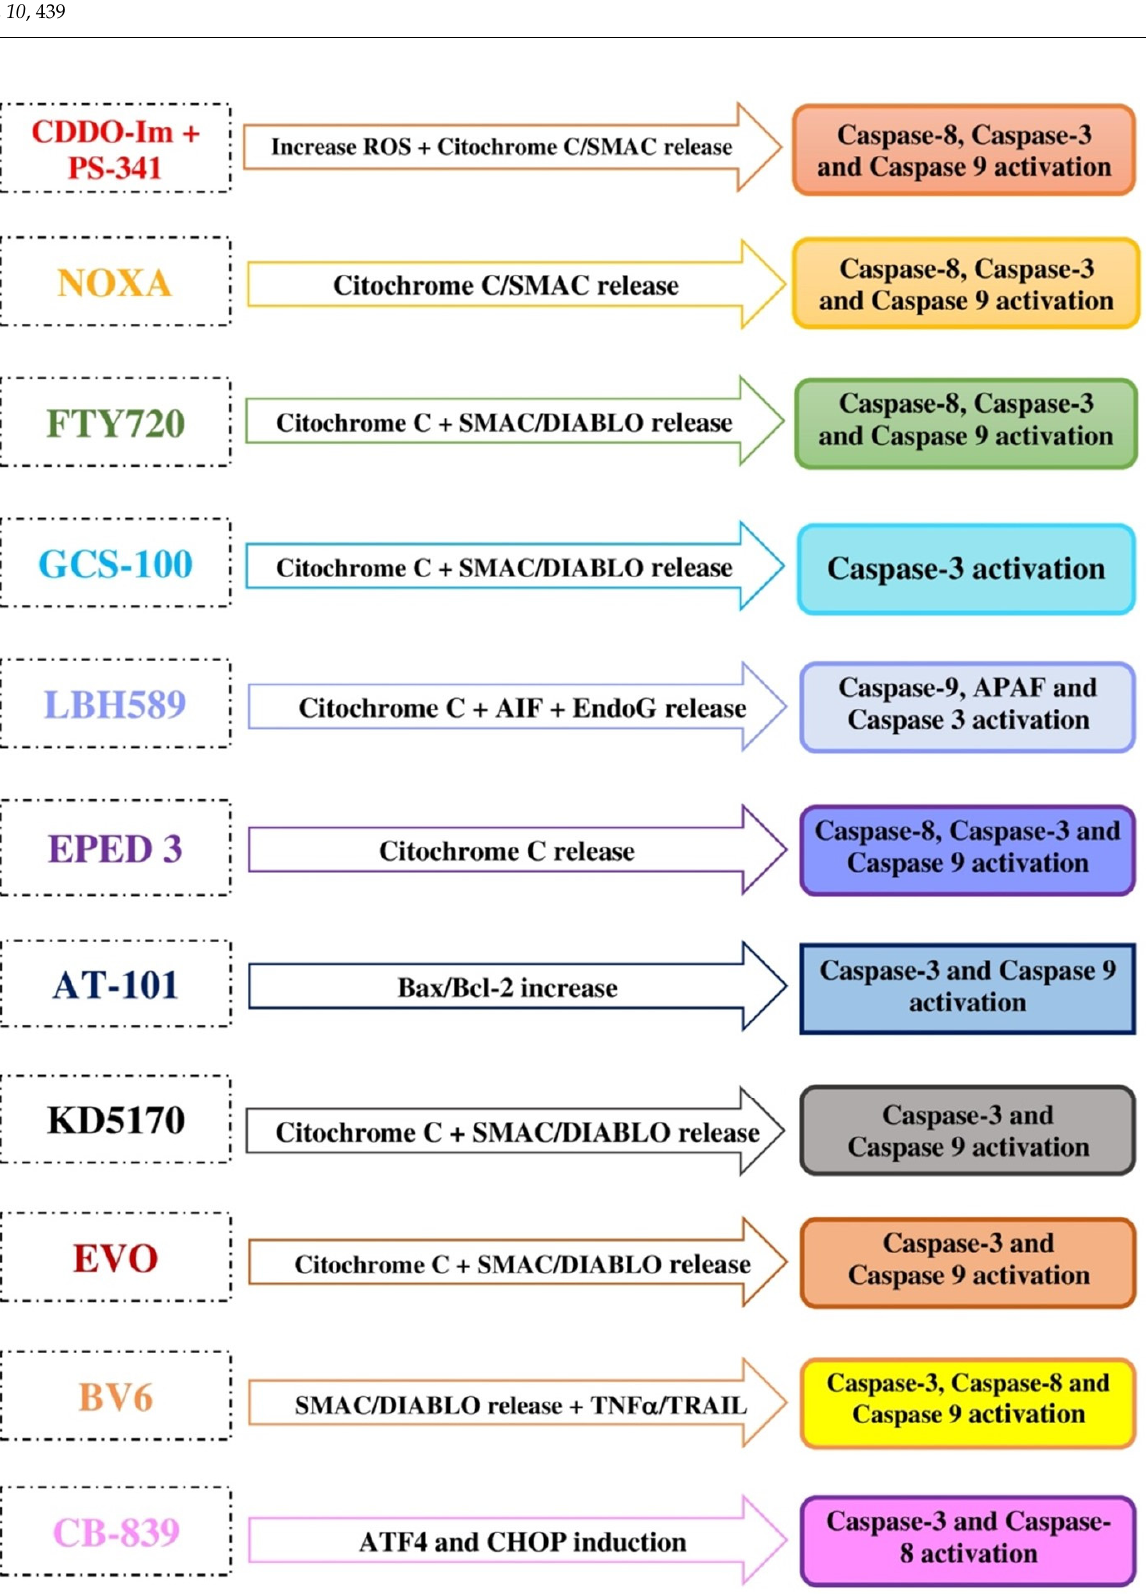
Figure 2. Anti-mitochondrial agents causing caspase-dependent apoptosis. CDDO-Im associated with PS-341 induces apoptosis in multidrug-resistant MM cell lines targeting several pathways, such as caspase-8, capsase-3, and caspase-9 activation and mitochondrial cytochrome c and SMAC release into the cytosol, but also via ROS; NOXA causes MM cell death, inducing cytochrome c release into the cytosol, followed by a proteolytic cascade involving caspase-9, -3, and -8; FTY720 with Dexa and anti-Fas antibodies reverts MM cells’ drug resistance, causing an increase in the permeability of the mitochondrial membrane, followed by cytochrome c and SMAC/DIABLO release into the cytosol, and activates proapoptotic Bax, resulting in the activation of caspase-8, -9, and -3; GCS-100 induces caspase-3 activation in BTZ-resistant